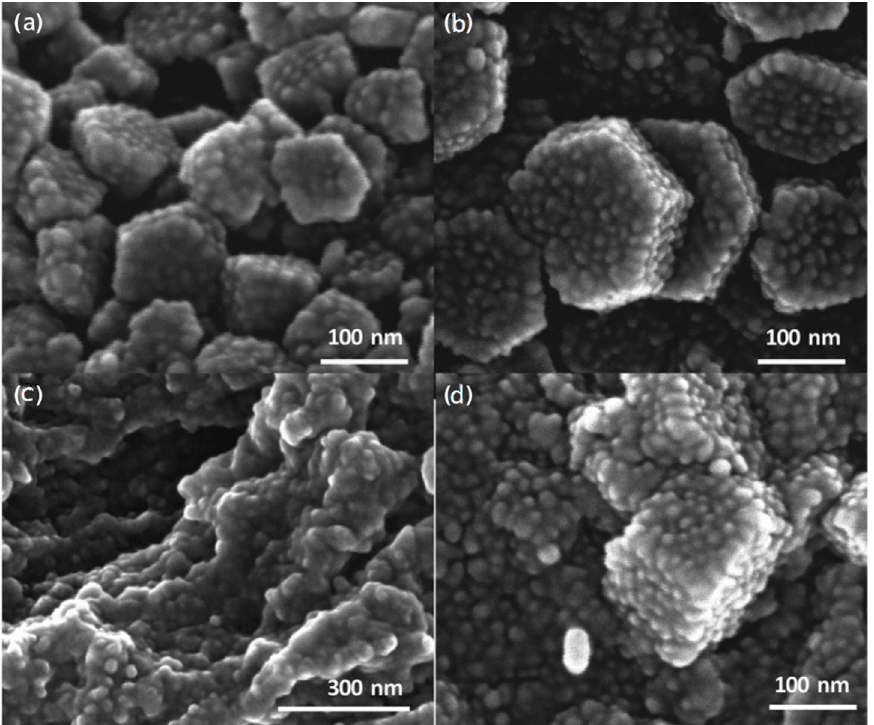
Figure 20. SEM micrographs of alumina nanospheres templated by hyperbranched PEI for different quantities of nano-dispersed boehmite (( a ) 0.02, ( b ) 0.04, ( c ) 0.06, and ( d ) 0.08 g/mL) (Reproduced with permission from [146]; Copyright The American Ceramic Society, 2018).